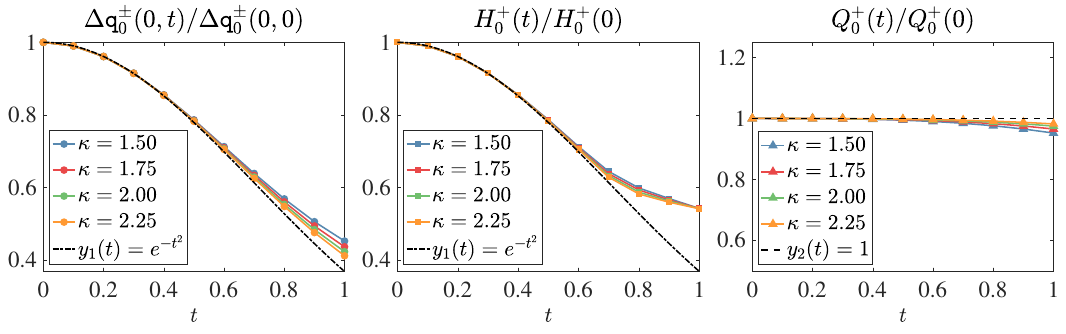
Figure 4 . Early times behaviour for various values of κ and no bath. The function ∆ q (0 , t ) / ∆ q (0 , 0) scales as e − t 2 , as predicted analytically (3.18). The same scaling is found 0 0 for H + ( t ) /H + (0) for early times, which is expected, as explained below. The range of times for 0 0 which the gaussian fit works well is roughly t 0 . 8 similar to a free fermion. The function Q + g < on the other hand is nearly time-independent for early times. This is related to the presence of interaction, which for very early times holds the subsidiary peak together, before it starts to decay and loses its symmetry in the spacial